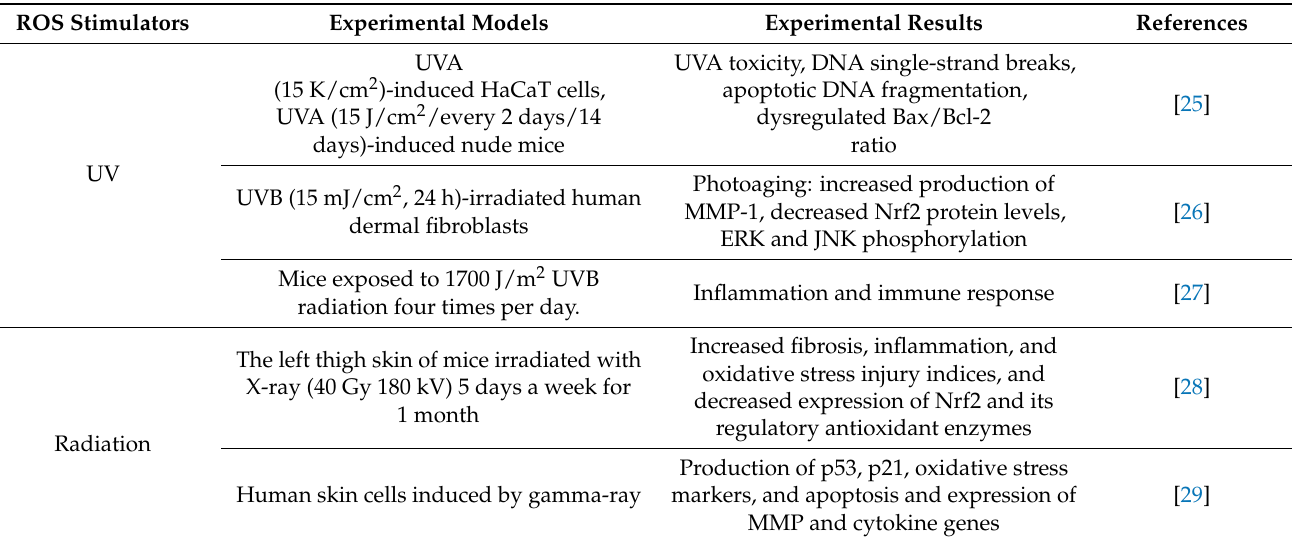
Table 1. Summary of exogenous factors and adverse consequences of ROS production in some ex- periments.